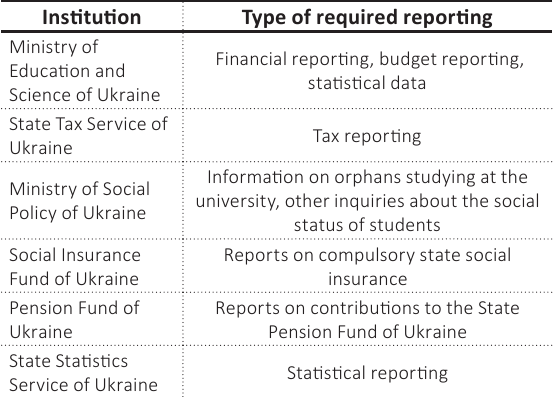
Table 1. Accountability of classical universities of Ukraine as of January 1,